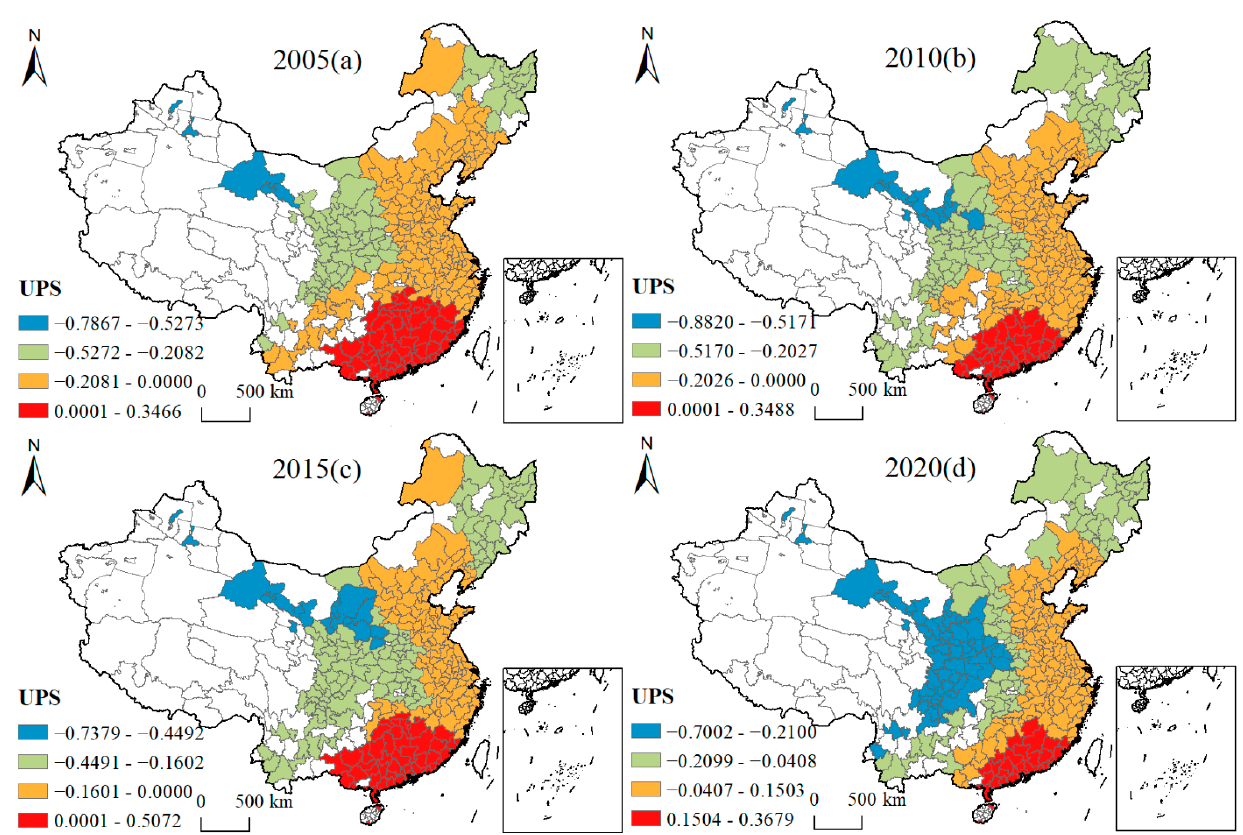
Figure 7. Four-year regression coefficients of UPS.